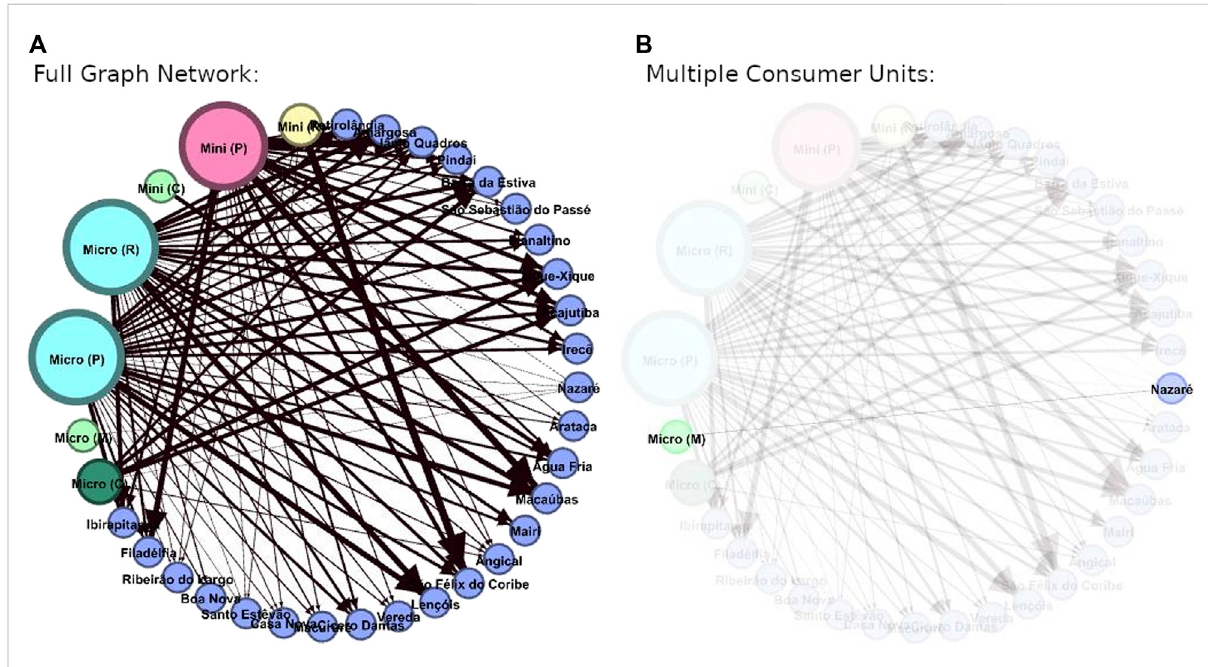
FIGURE 7 Graph of the micro-generation of energy on the self-consumption of the